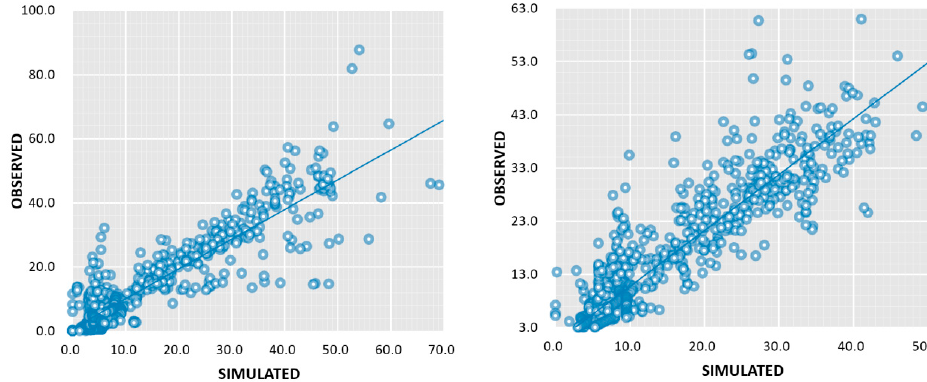
Figure 8. Deterministic coefficients of the daily observed and simulated runoff of Jinghe mountain station.